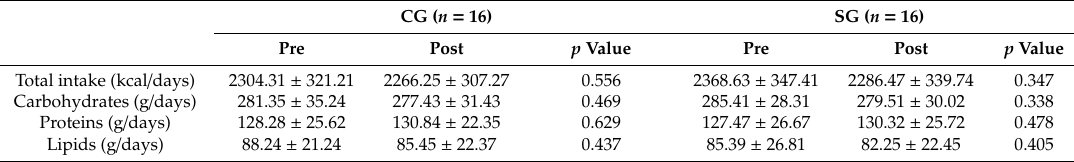
Table 3. Nutritional assessment in the first and the last weeks of the